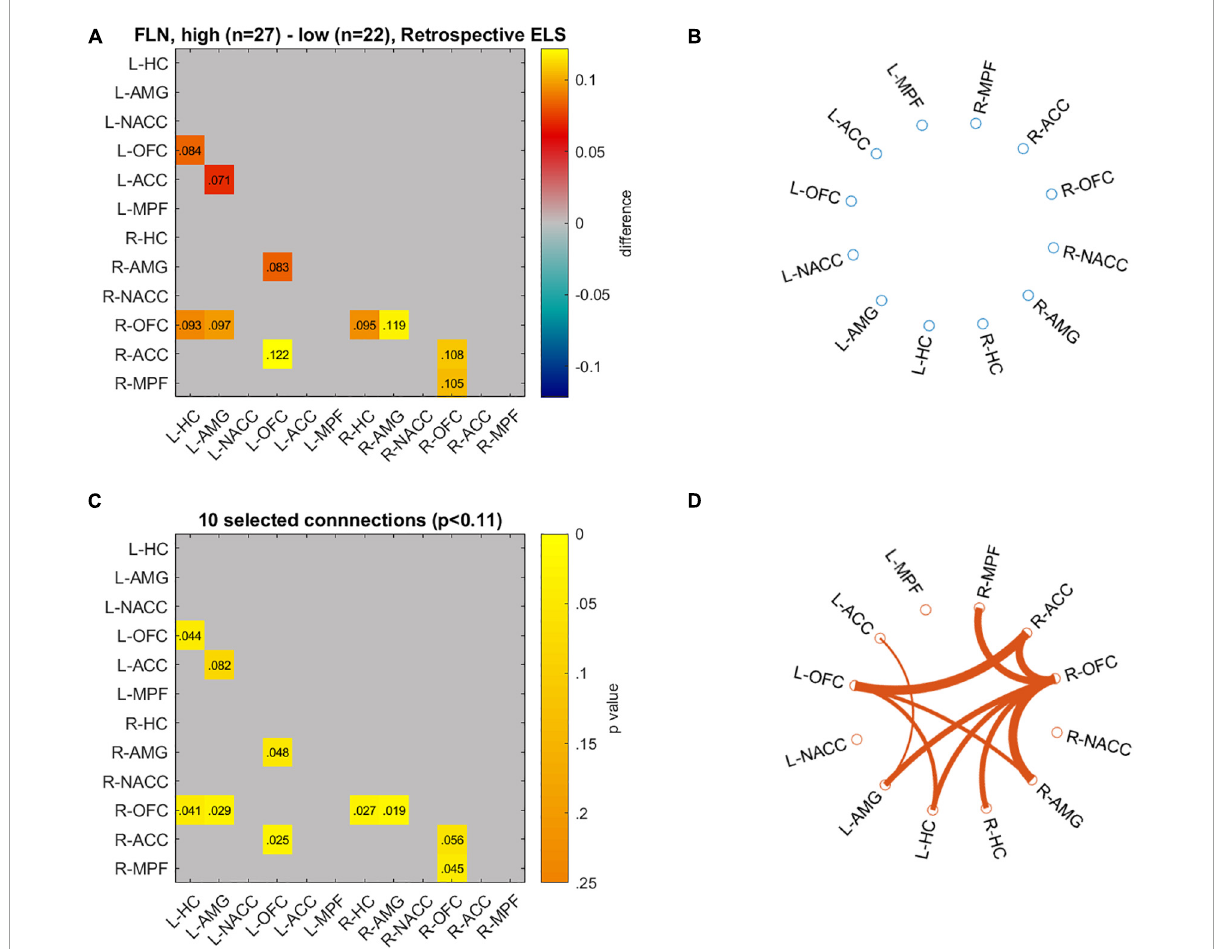
FIGURE6 Differences in network connectivity between participants with highest ( n = 27) and lowest ( n = 22) retrospective ELS values are plotted as mean difference (A) and p -values for these connections (C) . Circulographs of the negative ( B ; high retrospective ELS → reduced connectivity) and positive ( D ; high retrospective ELS → increased connectivity)